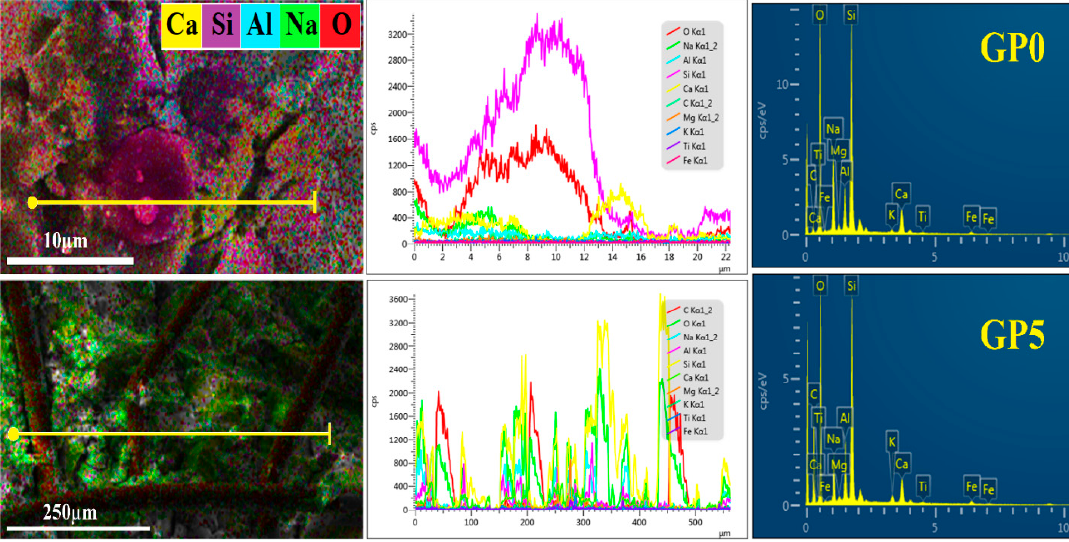
Figure 16. Energy-dispersive X-ray spectroscopy (EDS) analysis results.